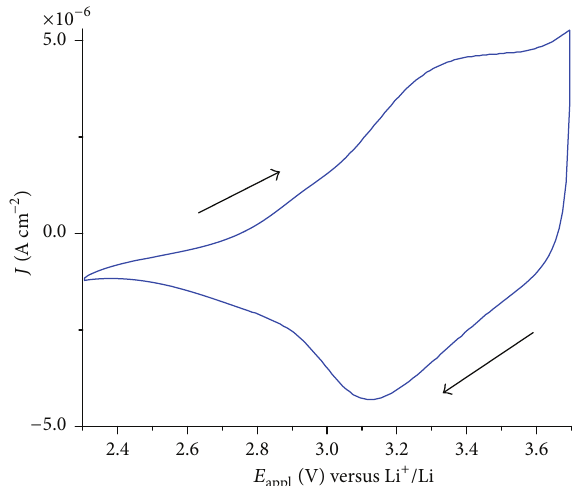
Figure 6: Cyclic voltammograms of CS NiO deposited onto ITO. Counter electrode: Li; reference redox couple: Li + /Li; scan rate: 5 mVs −1 . Electrolyte composition as in Figure 1. Arrows indicate the verse of potential scan.